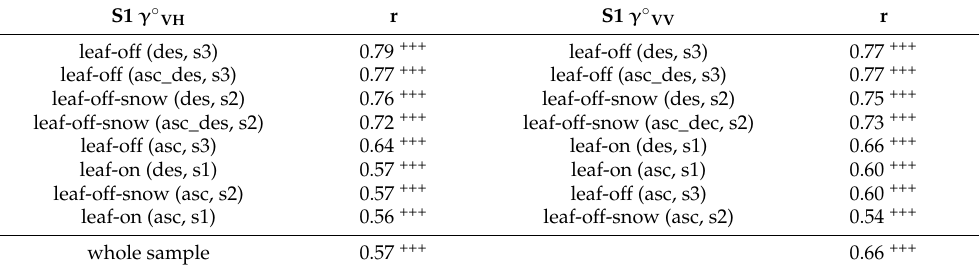
Table 4. Correlation coefficient between AGB and S1 γ ◦ radar backscatter in descending